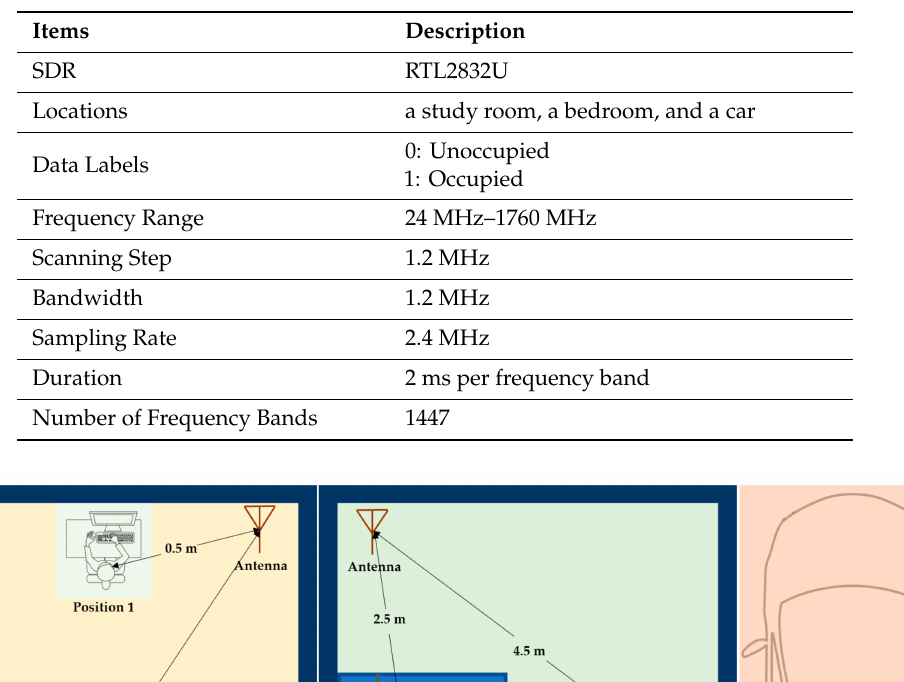
Table 1. Software-defined radio (SDR) configuration for passive RF data collection.